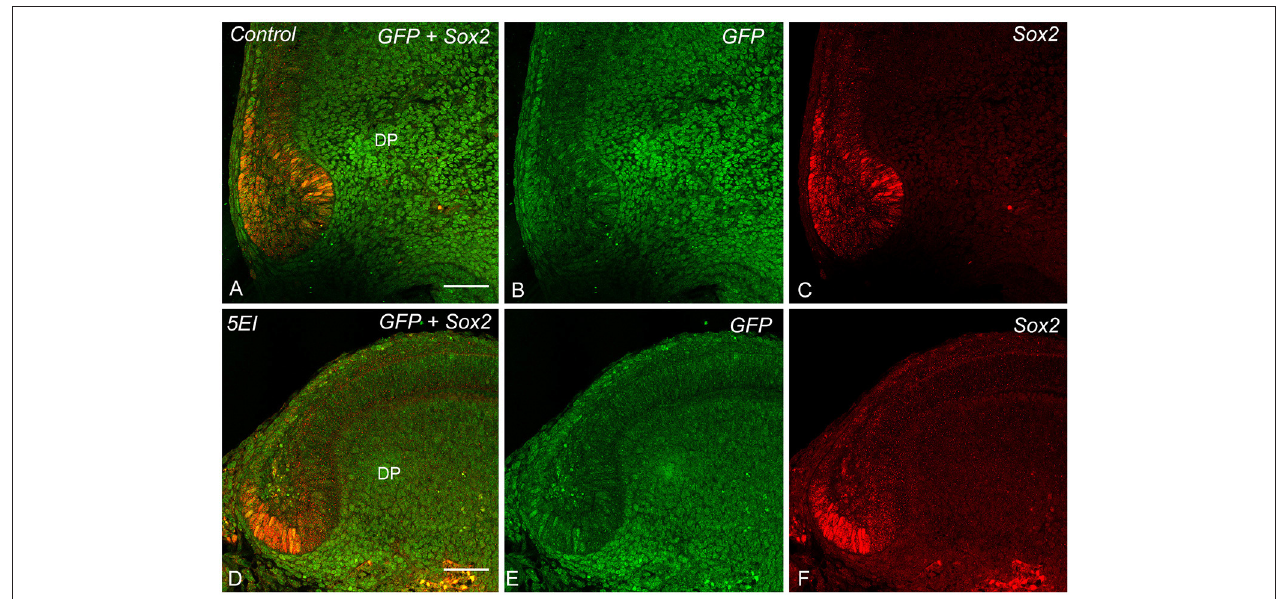
FIGURE 5 | GFP expression and Sox2 IR (A,D) , GFP expression (B,E) , and Sox2 IR (C,F) in control (A–C) and 5E1 explants (D–F) . Sox2 + cells decrease in number in the 5E1 group in the TetOP-H2B-GFP explants compared with those in the control. Scale bars: 50 µ